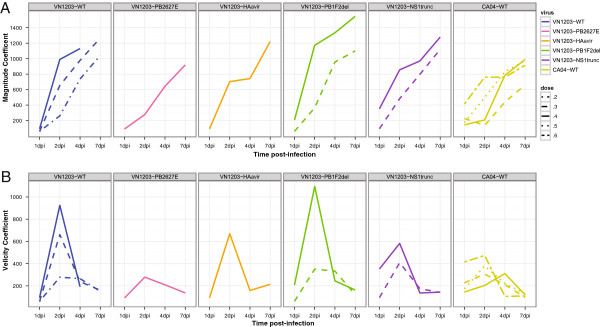
Profiles of Magnitude Coefficients and Velocity Coefficients for the different viruses and dosage conditions. (A) Variation of Magnitude Coefficients over time for the different viruses. (B) Variation of Velocity Coefficients over time for the different viruses. Profiles are colored by viral strain and line types represent the different doses. The Magnitude Coefficient (MC) quantifies the magnitude effect as the transcriptomic or proteomic distance from one biological condition to the matched mock-infected condition. The Velocity Coefficient (VC) quantifies the velocity effect as the speed of the transcriptomic host response to move from one time point to the next one. Both the MC and VC were calculated based on the centroids of the biological conditions and the transcriptomic or proteomic distances are calculated based on the lists of transcripts associated with the kinetics of the host response to VN1203 wild-type.